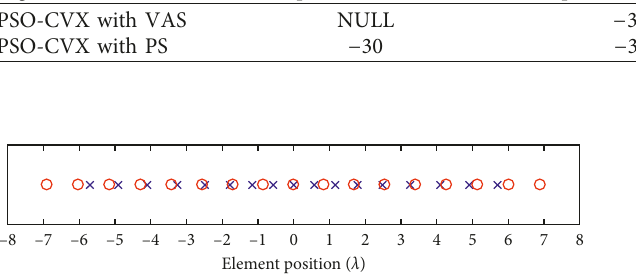
Figure 16: Position arrangement comparison of the sparse array with PS modulation and VAS modulation.